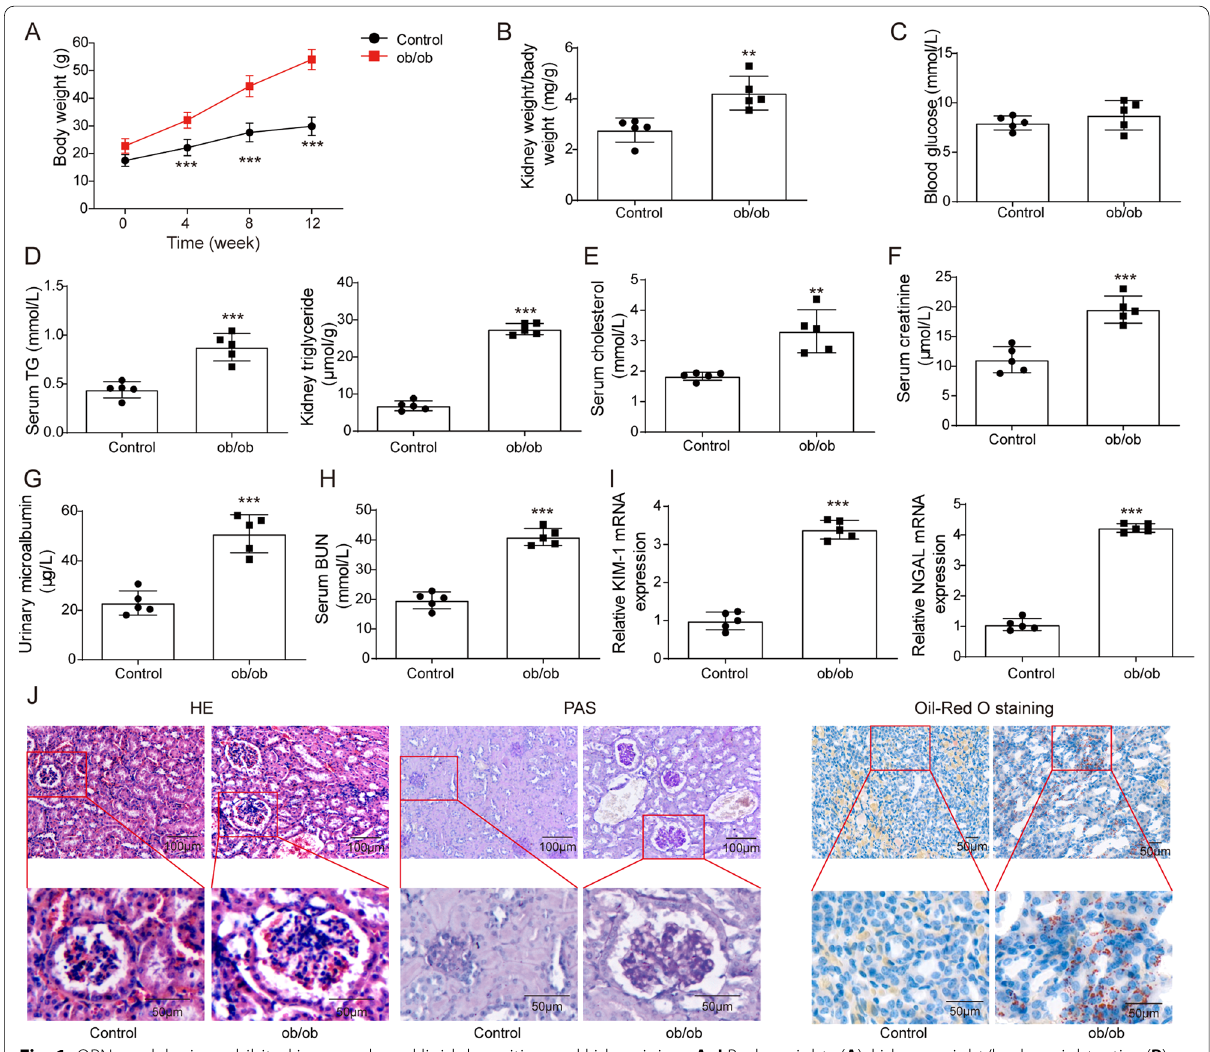
KIM‑1 and NGAL levels ( I ) of ORN model mice compared to control mice. J Kidney sections stained with HE, PAS and Oil Red O trichrome. ORN, obesity‑related nephropathy; TG, triglyceride; BUN, blood urea nitrogen; KIM‑1, kidney injury molecule‑1; NGAL, neutrophil gelatinase‑associated lipocalin; HE, haematoxylin and eosin; PAS, periodic acid‑Schiff. Significance was assessed by a Student’s t test. The experimental data are shown as the mean SD. N 10. *P < 0.05, **P < 0.01, ***P < ± =